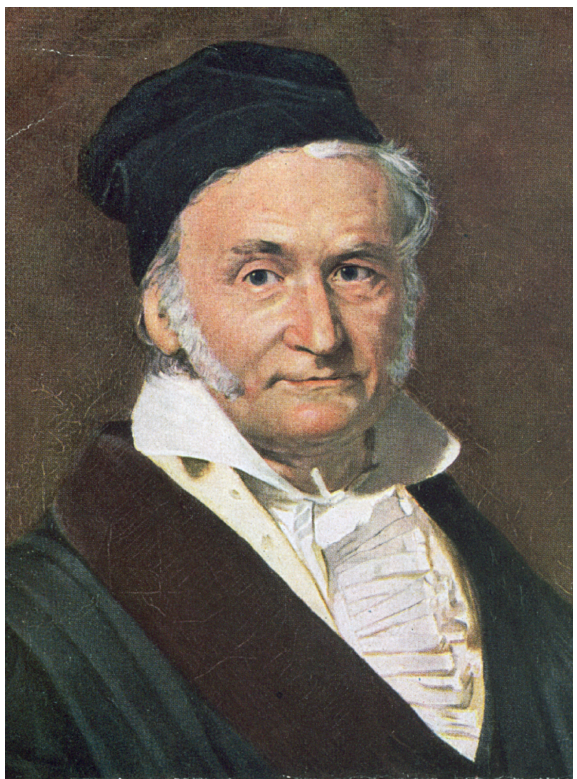
Figure 1. Carl Friedrich Gauss, painted by Gottlieb Bier- mann (1887). Reproduction by the author from a calendar dated June 1939; this is the first known colour print of a portrait of